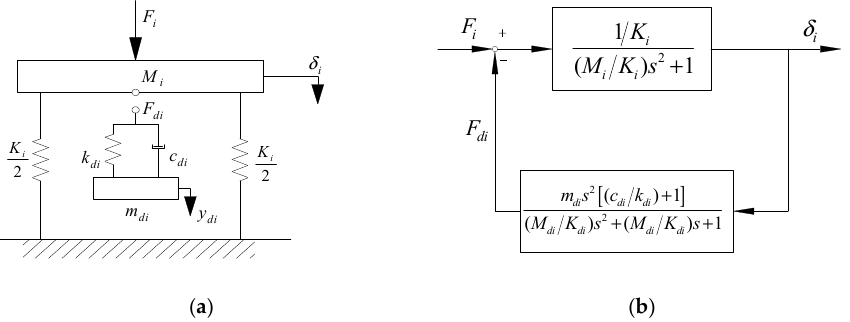
Figure 16. A simplified model diagram of the vibration reduction system is added to the single- degree-of-freedom system of the i -th Mode. ( a ) Mechanical model. ( b ) Control flow